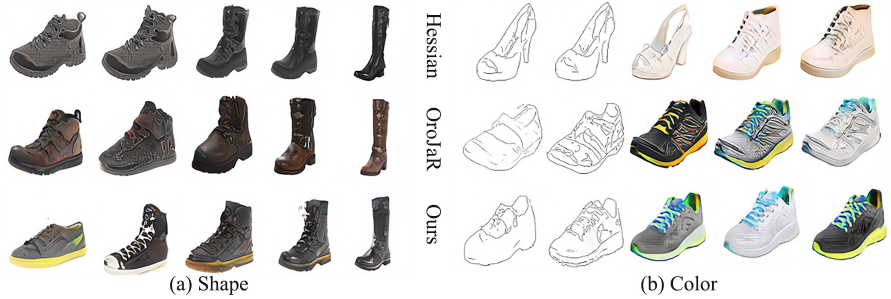
Figure 6. Comparison of the disentanglement quality of OroJaR [14], Hessian penalty [13] and our method for Edge +